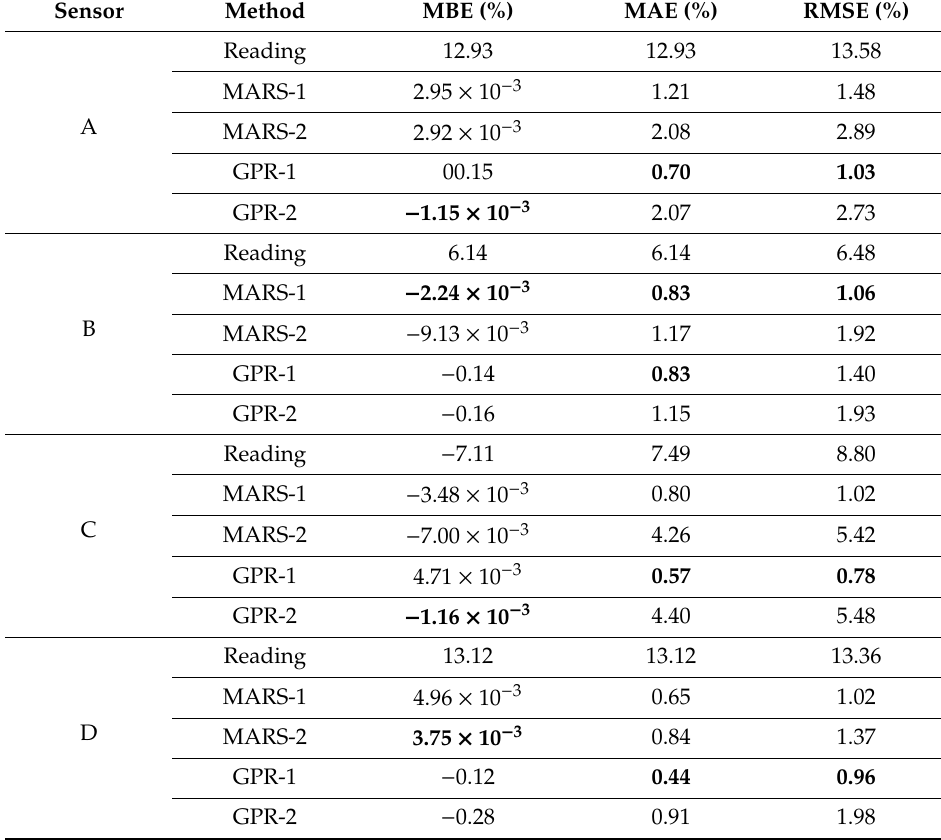
Table 5. Modeling performance comparison (the best values are in